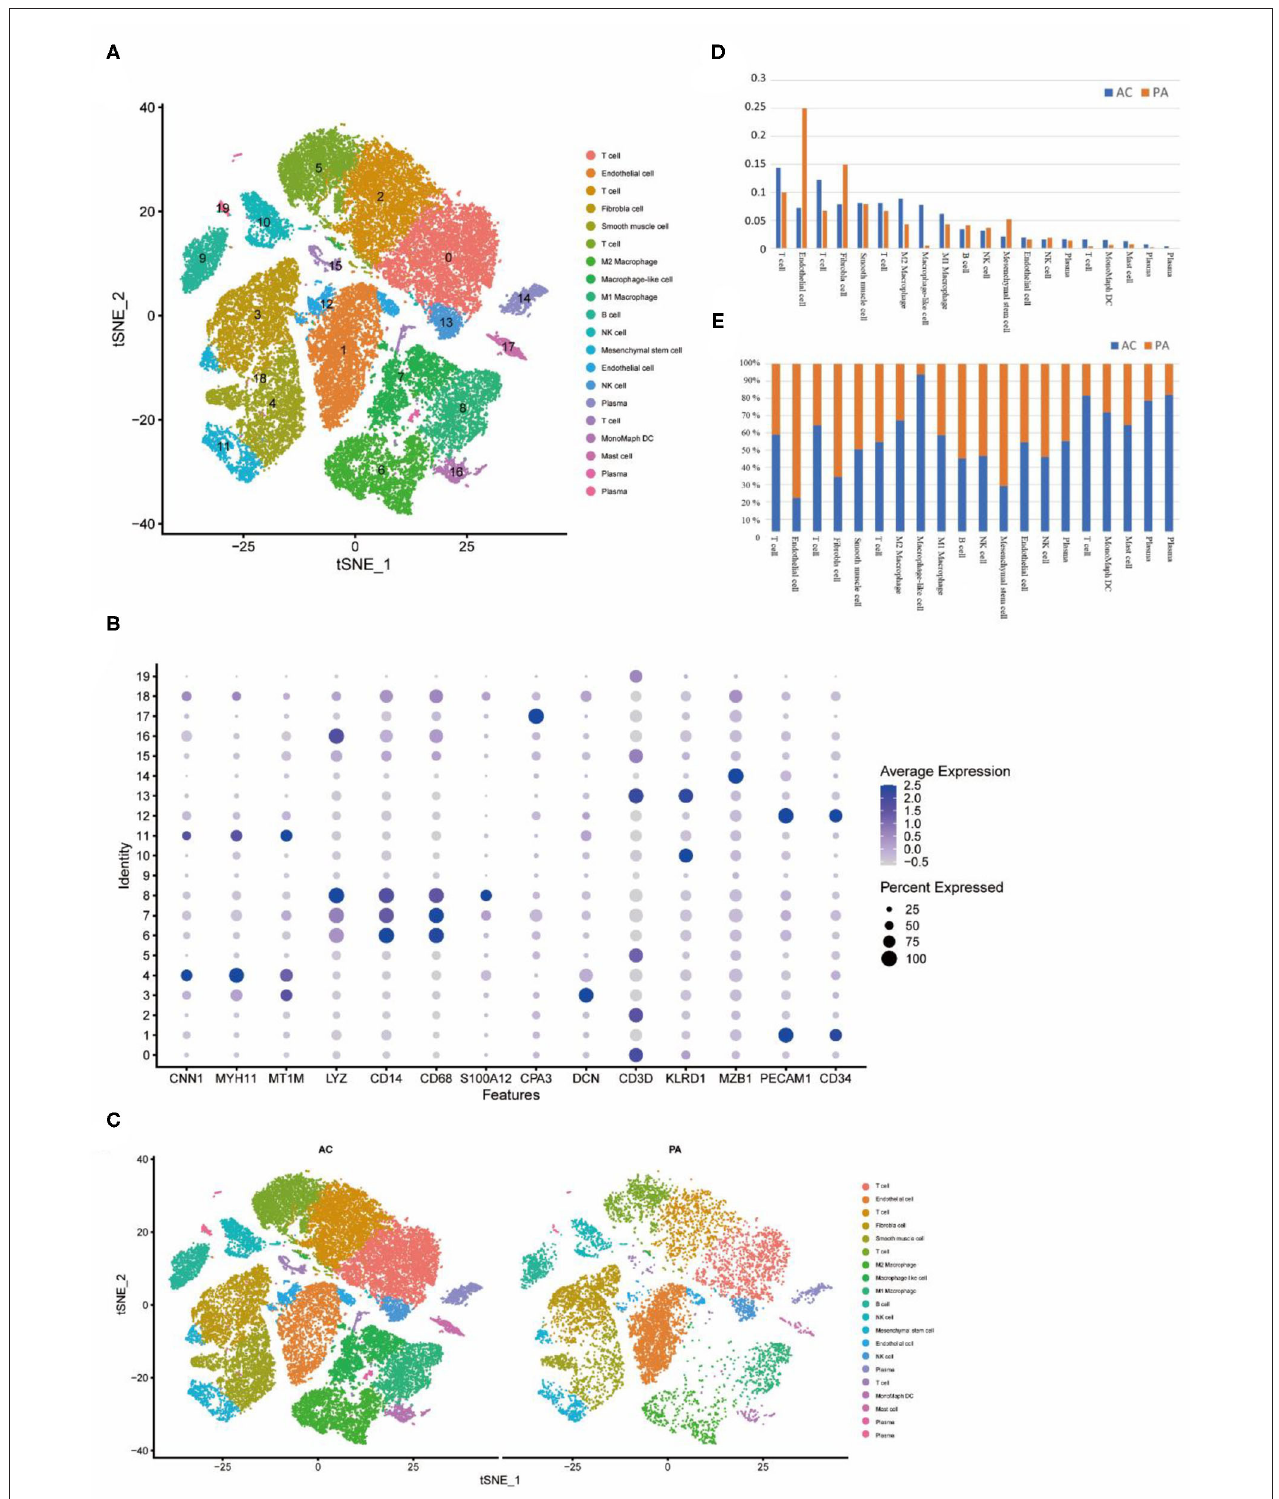
FIGURE 2 | Cellular annotation of subpopulations of calcified core cells, grouped and shown in varying proportions. (A) The tSNE algorithm was applied to downscale the 20 PCs and divide the cells into 20 cell clusters. (B) Identification of markers for different cell clusters. (C) Different cell clusters have different proportions in AC and PA respectively. (D) Proportions of each of the 20 cell clusters in AC and PA respectively. (E) Variation in the proportion of the 20 cell clusters in AC and PA, with closer to 50% representing less variation.